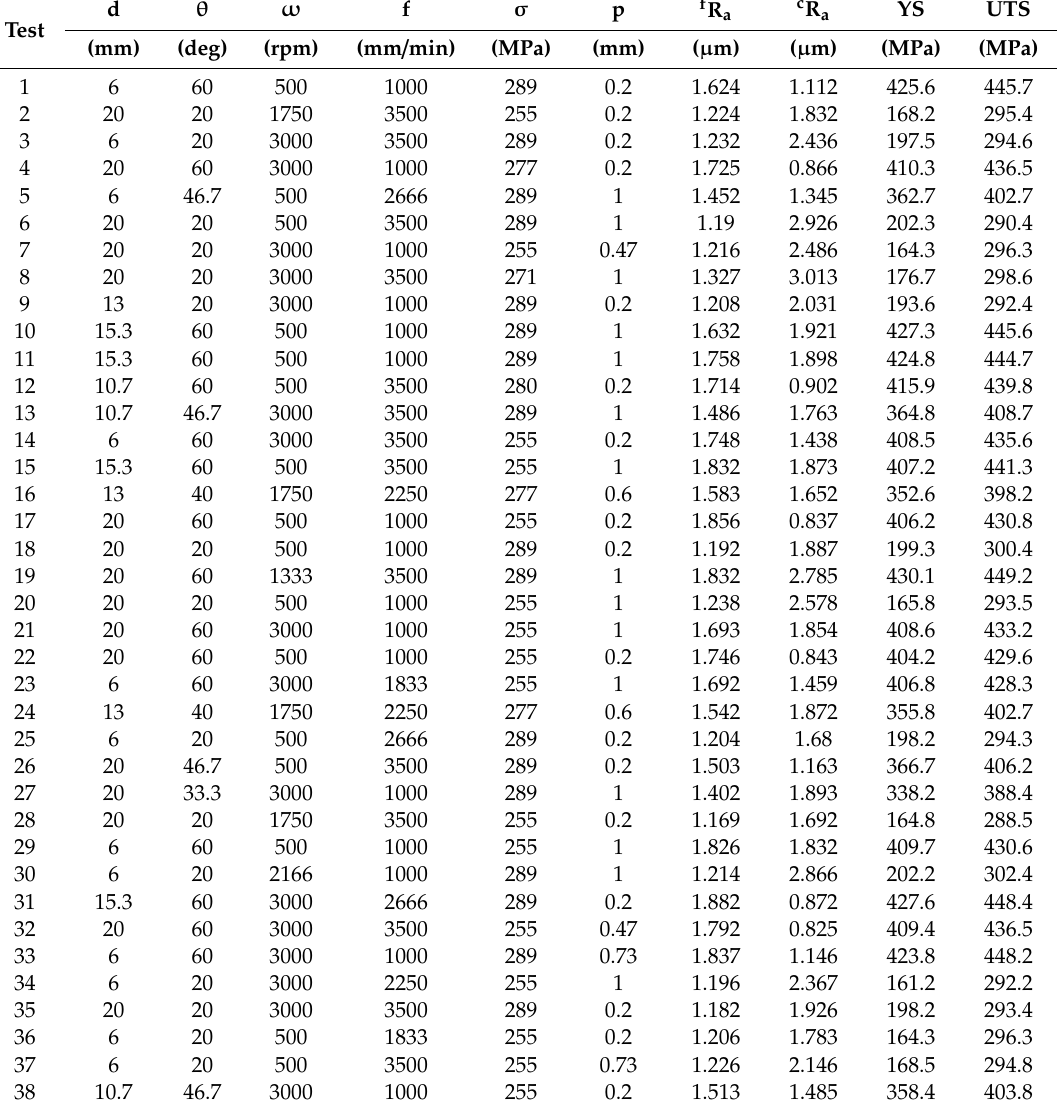
Table 1. The experimental plan and